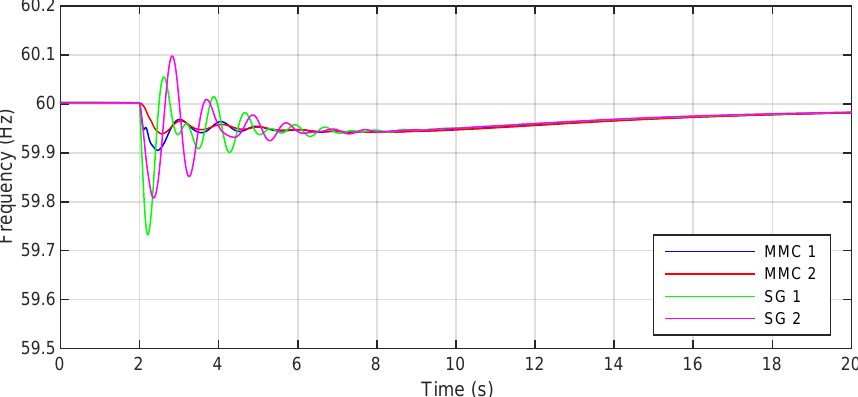
Figure 8. Frequency behavior of the elements of the test system after disturbance in Scenario